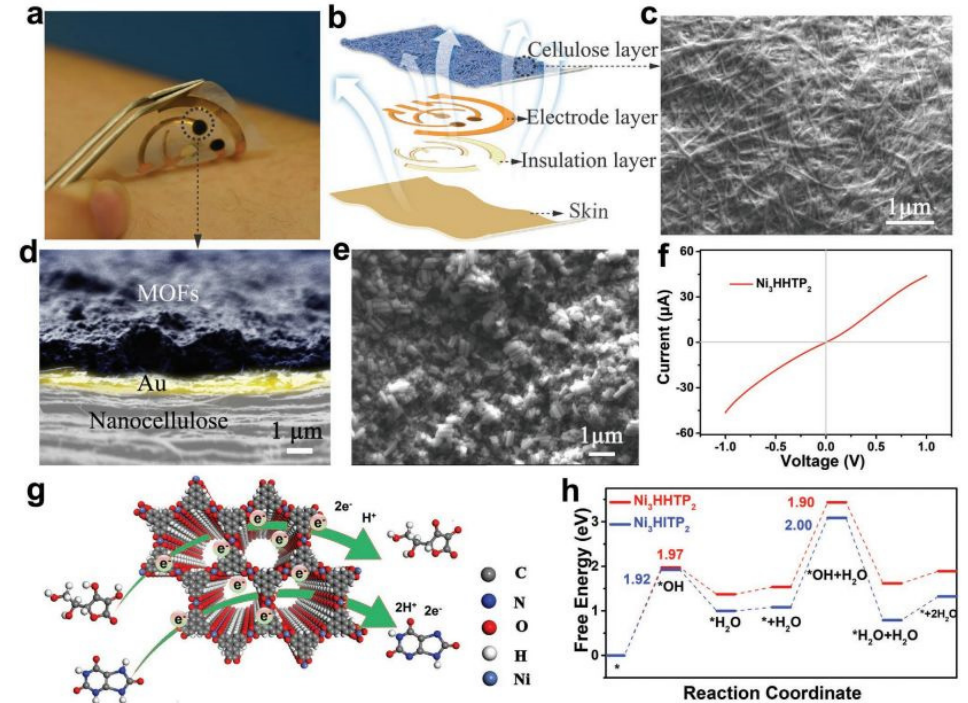
Figure 8. Design and structure of cMOF − based wearable sweat sensors. ( a ) Photograph of the wearable sweat sensor that self-adheres to the sweaty skin of humans. ( b ) Configuration of the layered film sensor, which comprises cMOF, electrode, cellulose, and insulation layers (Ecoflex was used as an insulating layer to encapsulate the interconnected area and avoid contact of the conductive interconnected path with the skin and perspiration). ( c ) SEM image of the prepared BNC membrane. ( d , e ) Sectional view and top view SEM images, respectively, of the Ni 3 HHTP 2 − based working electrode. ( f ) Current–voltage characteristic of Ni 3 HHTP 2 measured using the two-contact probe method. ( g ) Schematic illustration of the oxidation mechanism of AA and UA catalyzed by Ni 3 HHTP 2 . ( h ) The free energy diagrams for AA electrocatalytic oxidation on Ni − based cMOFs using DFT calculations. Reproduced with permission from [47]. Copyright 2022 John Wiley and Sons.